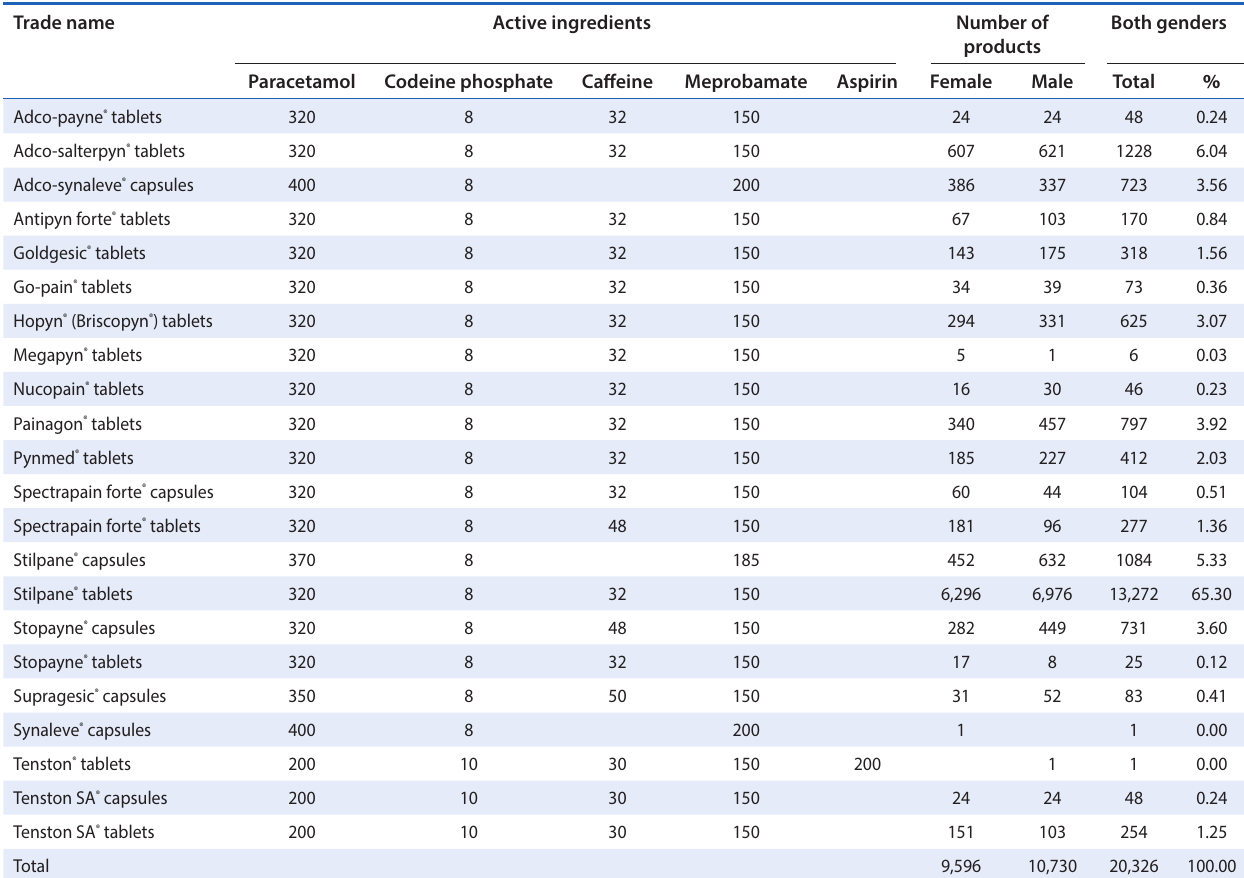
Table 2: Prescribing frequency of meprobamate-containing combination analgesics according to gender Trade